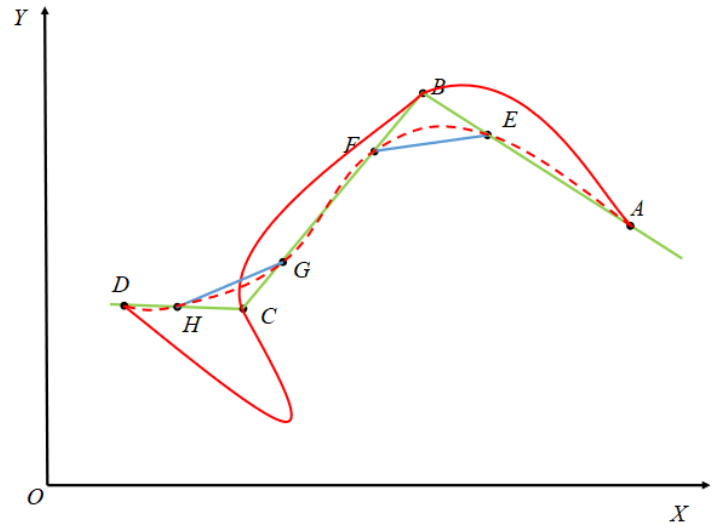
Figure 6. Comparison diagram of trajectories before and after trajectory correction.